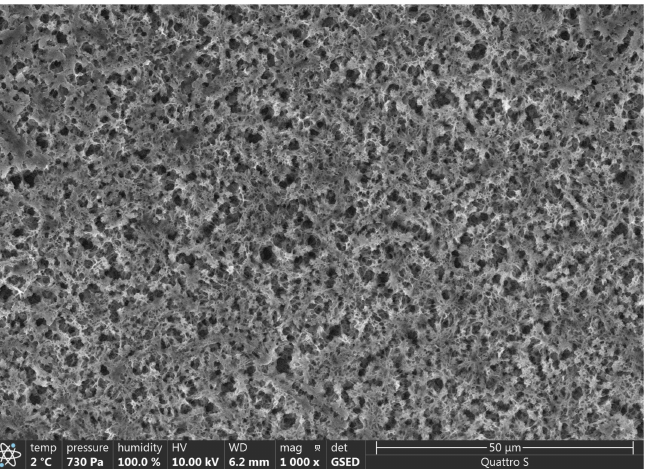
Figure 2. Illustration showing the magnification of Product E (1000 × ). Impurity particles were not